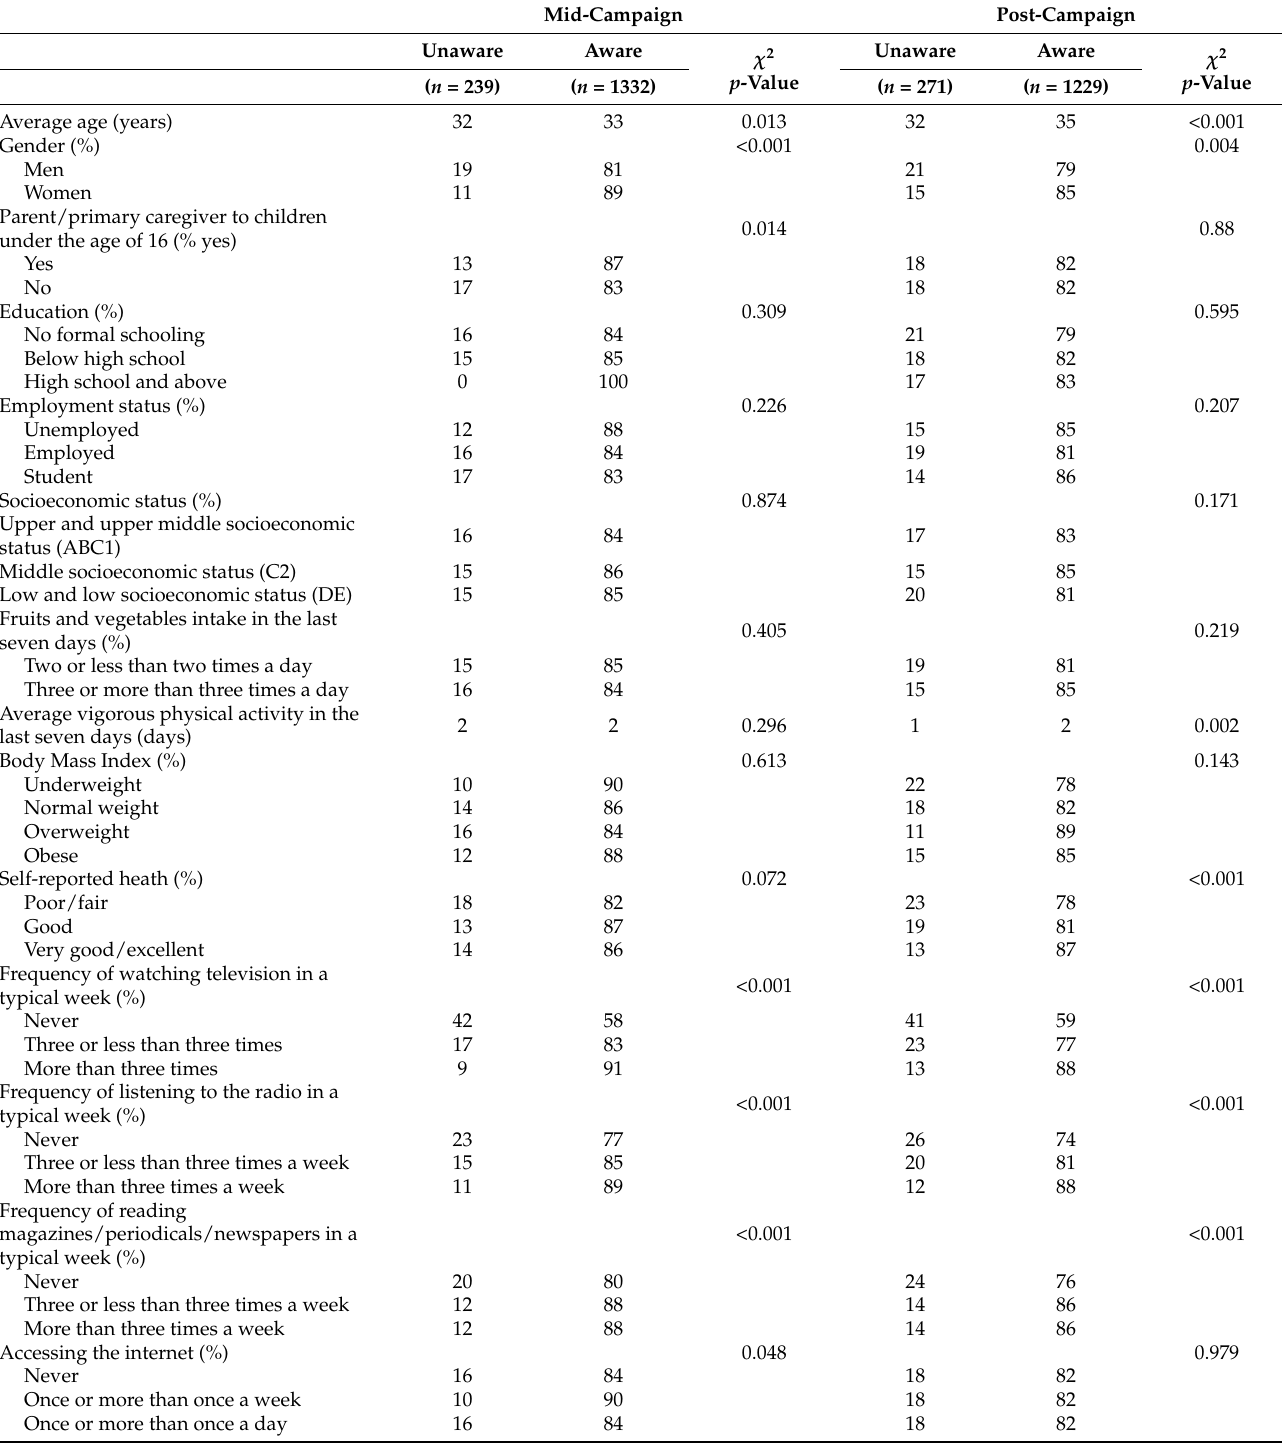
Table 3. Demographic characteristics of campaign-aware and campaign-unaware respondents in the mid-campaign survey and post-campaign survey